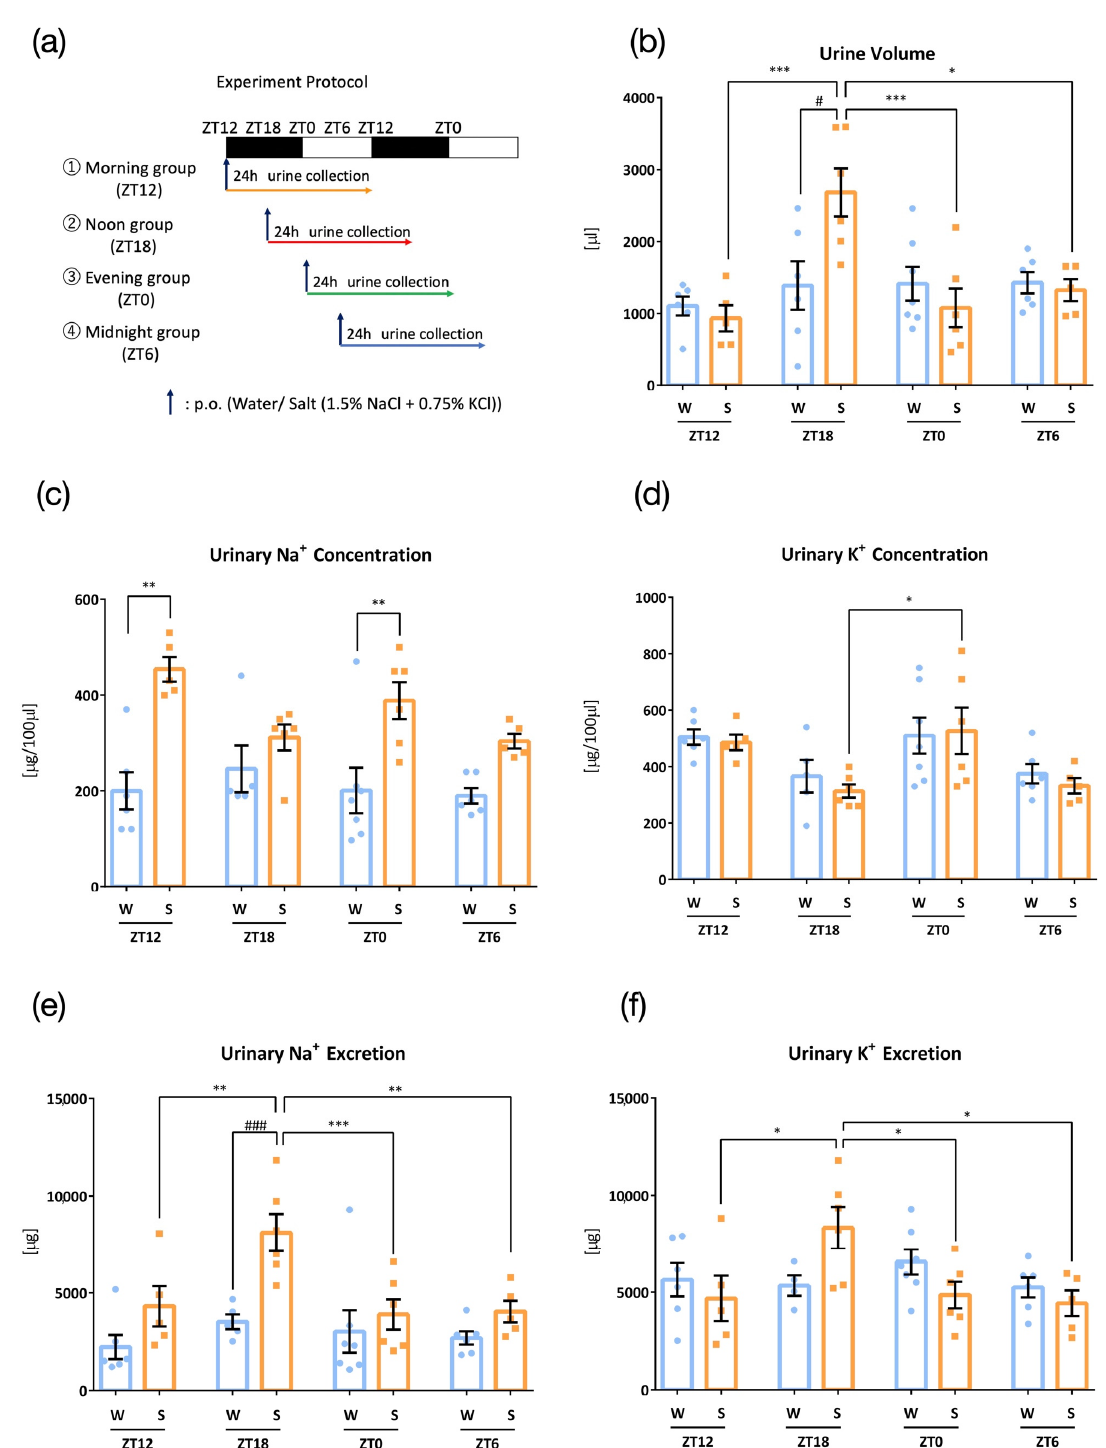
Figure 1. Urinary excretion after administration of salt load at four time points (W: Water administration, S: Salt administration). ( a ) Experimental protocol, ( b ) Urine volume, * p < 0.05, *** p < 0.001 (vs. zeitgeber time 18 (ZT18)), # p < 0.05 (vs. water) Tukey. ( c ) Urinary Na + concentration, ** p < 0.01 (vs. ZT6) Benjamini, Krieger, and Yekutieli’s two-stage test. ( d ) Urinary K + concentration, * p < 0.05 (vs. ZT18) Tukey. ( e ) Urinary Na + excretion, ** p < 0.01, *** p < 0.001 (vs. ZT18), ### p < 0.001 (vs. water) Tukey. ( f ) Urinary K + excretion, * p < 0.05 (vs. ZT18). Data are represented as mean ± SEM (ZT12 group: n = 5 – 6, ZT18 group: n = 7 – 8, ZT0 group: n = 6 – 7, ZT6 group: n = 5 – 6) .